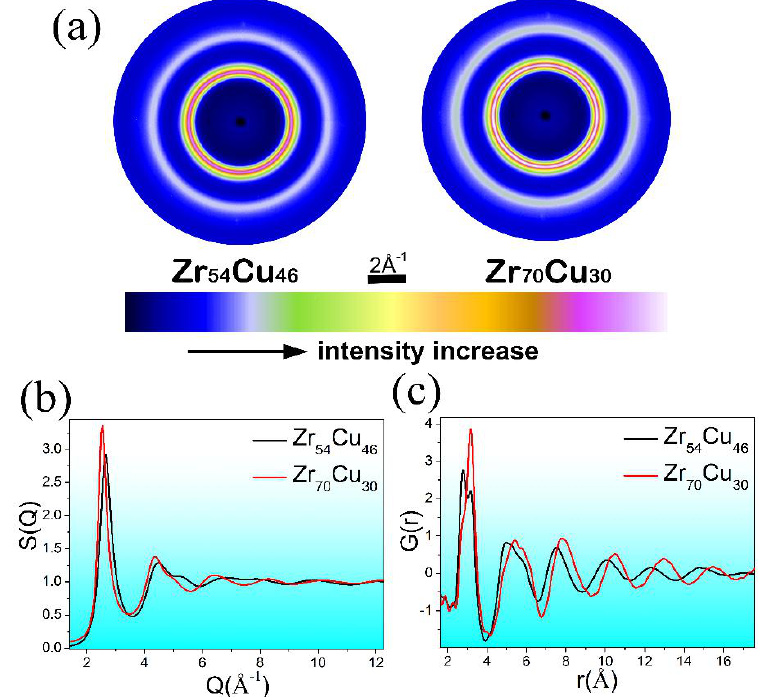
Figure 2. ( a ) The two-dimensional X-ray diffraction patterns of both ZrCu amorphous samples; and the deduced data: ( b ) the structural factor ( S ( Q )); and ( c ) the total pair distribution function ( G ( r )). To highlight the S ( Q ) difference between Zr 70 Cu 30 and Zr 54 Cu 46 , the Q region here was shortened to about 12 Å −1